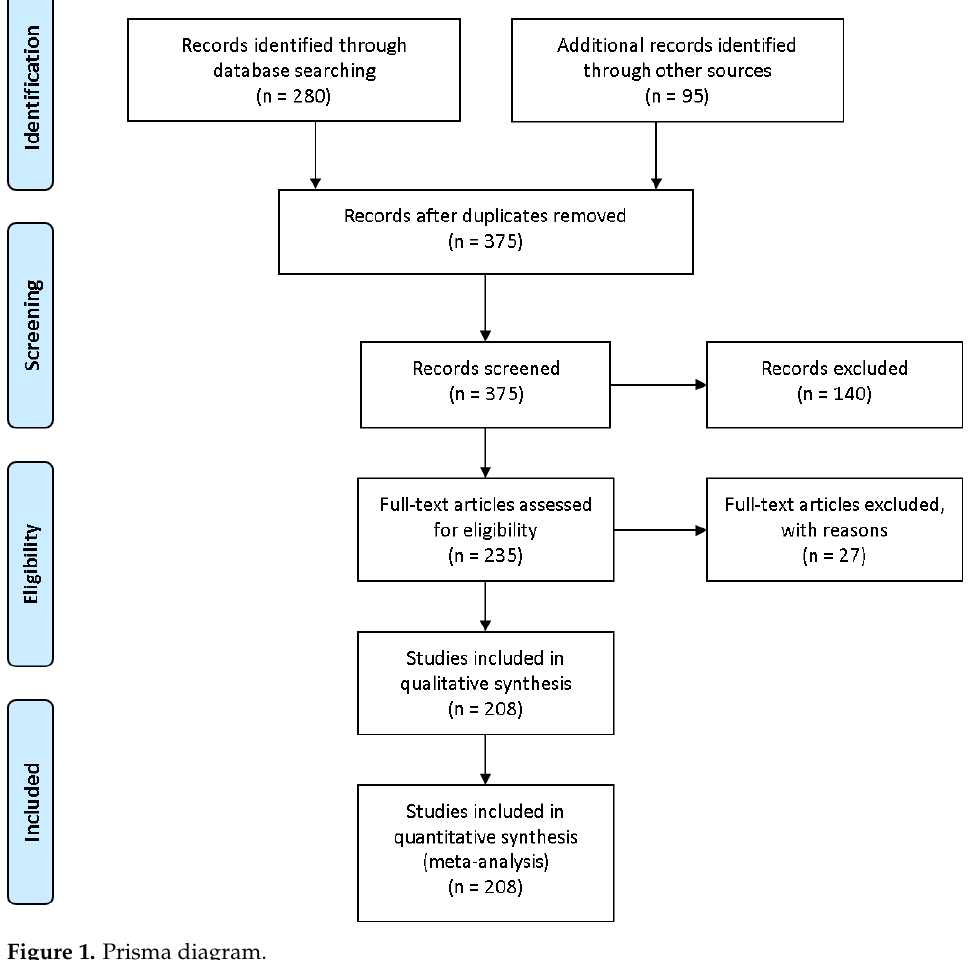
Figure 1. Prisma